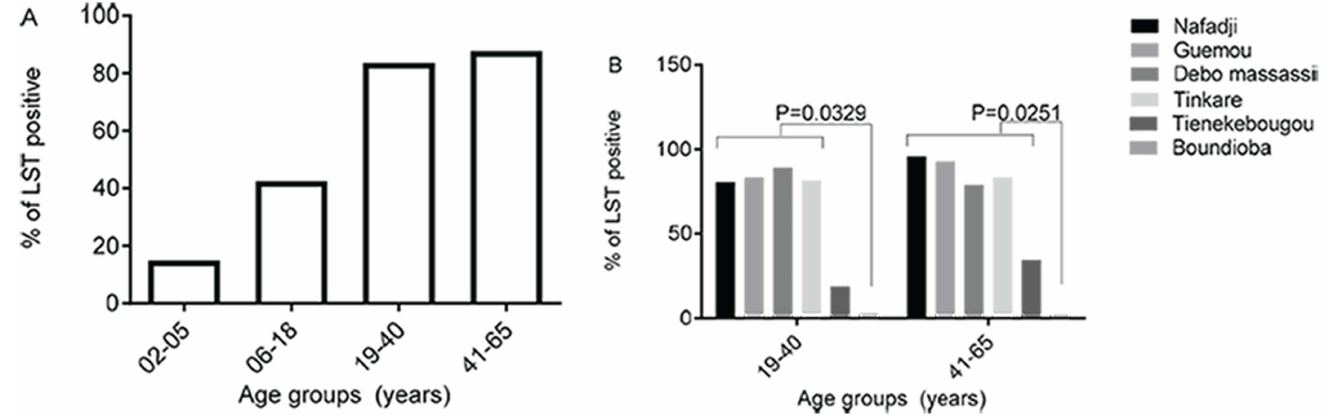
Fig 3. Prevalence of LST positivity by age group for the district of Diema (A) and for all study sites (B).